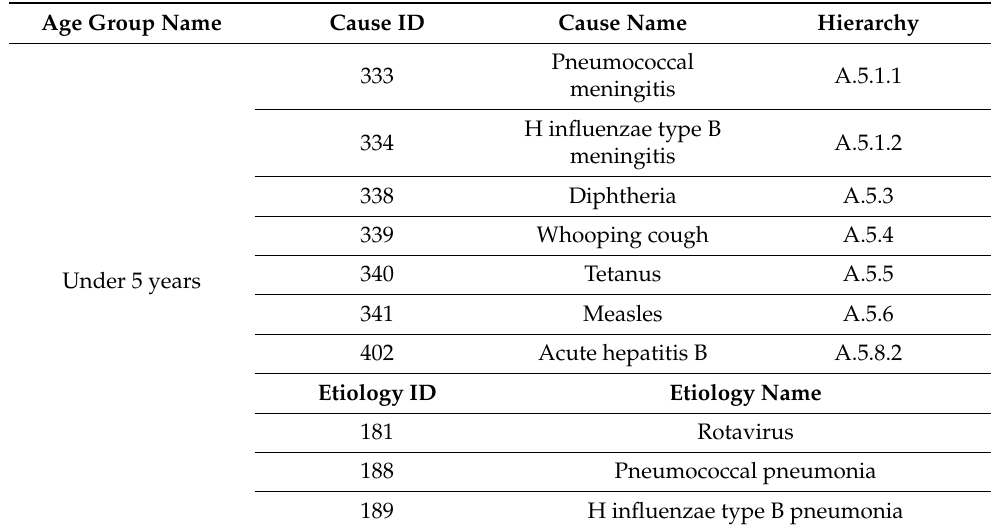
Table 3. DALYs data